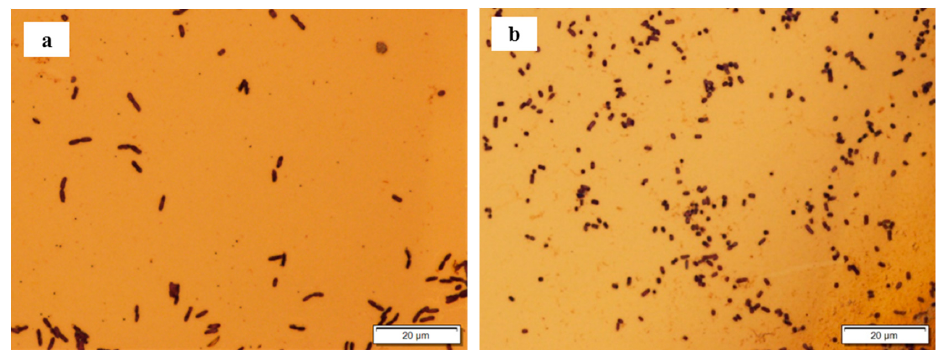
Figure 3. Micrographs of biosensor surfaces after exposure to the suspensions obtained after spinach leaves were incubated in ( a ) lactose broth, and ( b ) LB broth.